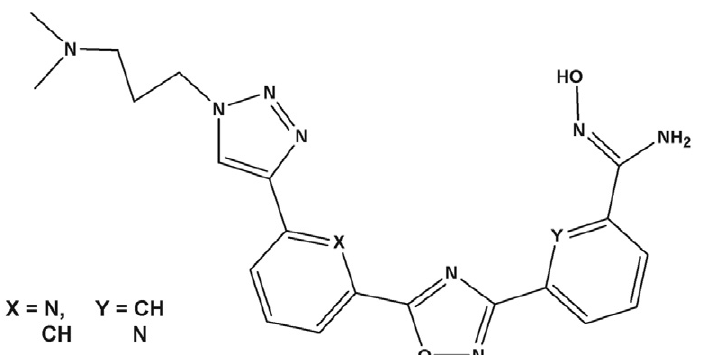
Figure 10. One of the heterocyclic molecules was shown to prefer G4 from the HIV-1 LTR promoter region and to represent a potential pharma- cophore for the development of novel ligands with unexpected chemical features. These compounds were developed using a FBDD approach.